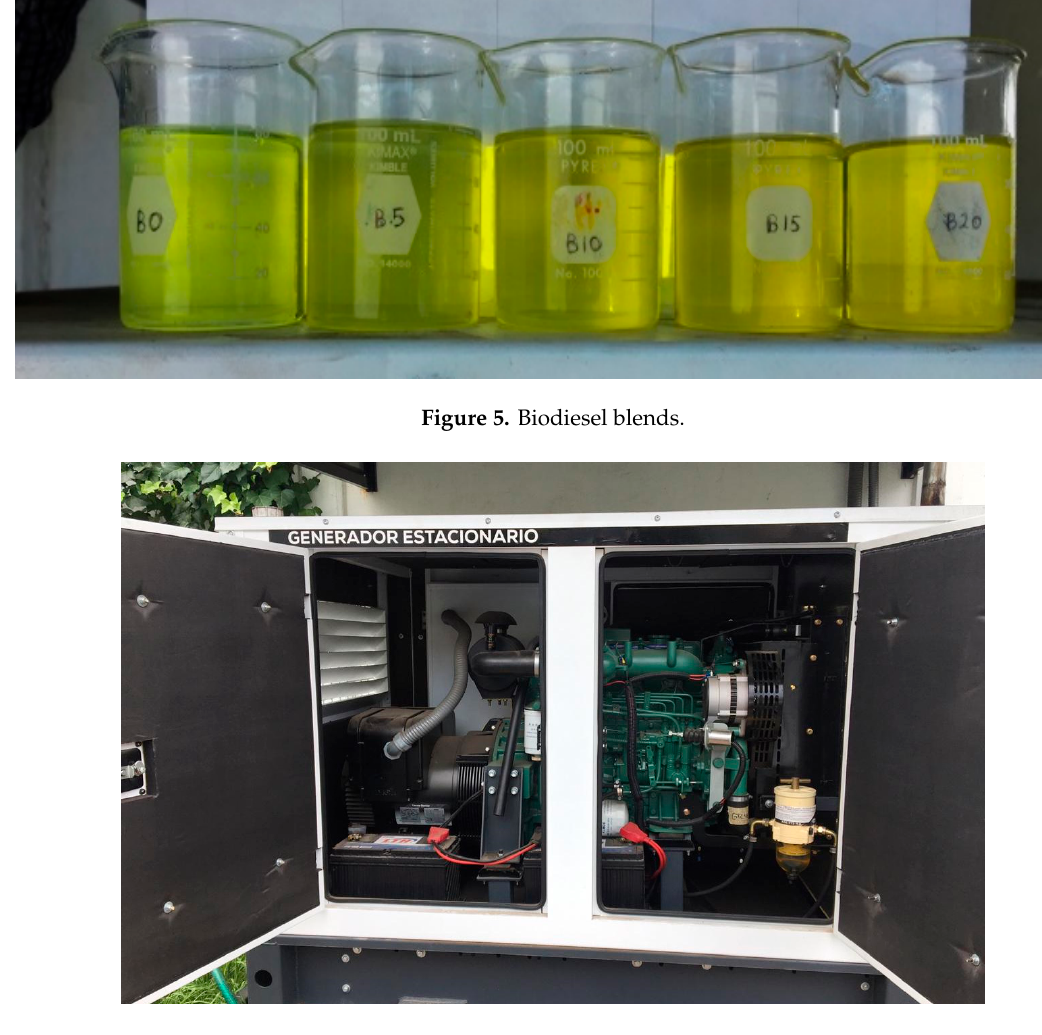
Figure 6. Experimental emissions tests in an electric generator.